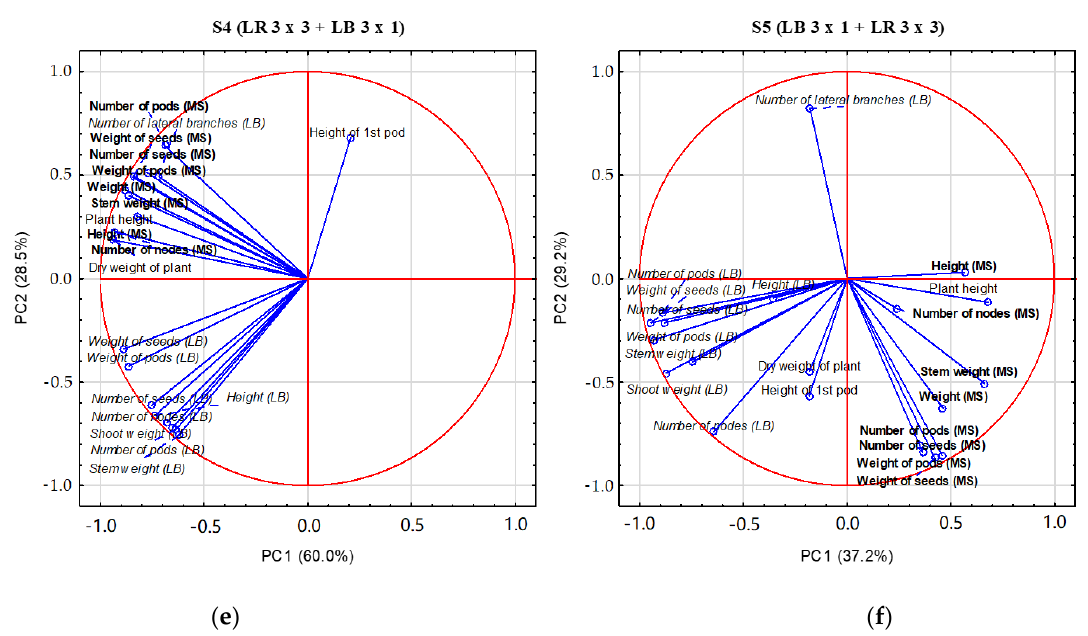
Figure 3. Principal component analysis of PC1 and PC2 on yield and biological parameters of soy- bean located on the main shoot (MS) and lateral branches (LBs), depending on laser stimulations: ( a )— Control, ( b )—S1 (LR 3 × 3), ( c )—S2 (LR 3 × 9), ( d )—S3 (LR 3 × 30), ( e )—S4 (LR 3 × 3 + LD 3 × 1), ( f )—S5 (LD 3 × 1 + LR 3 ×